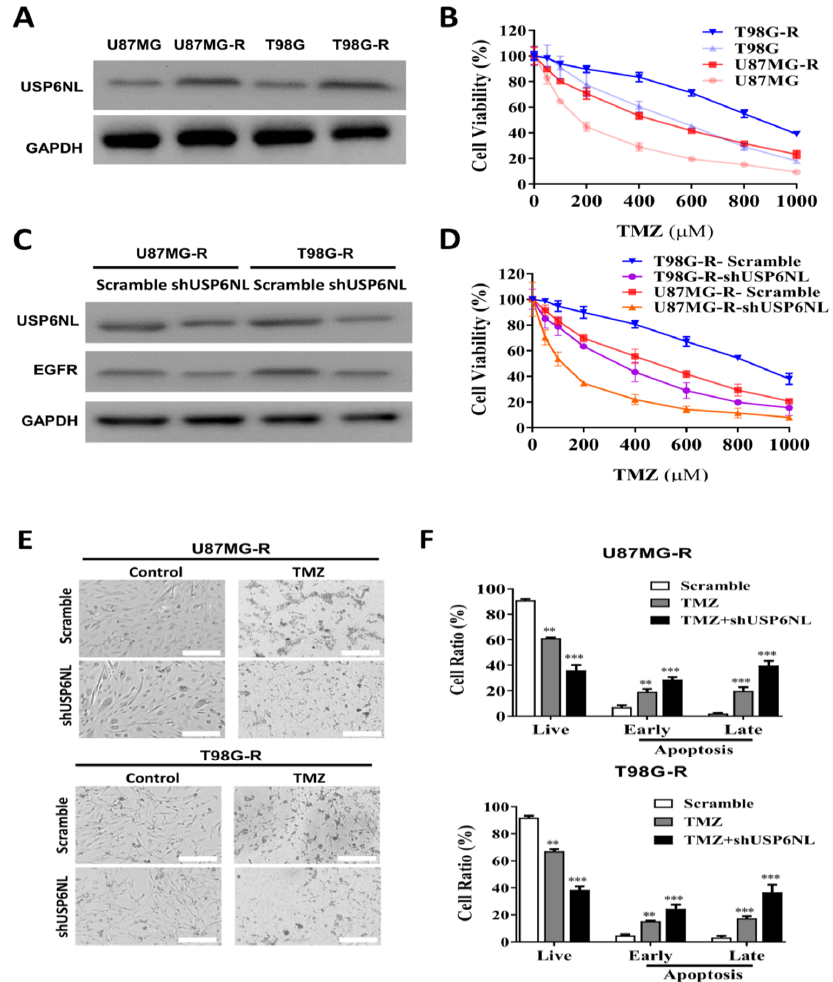
resistant cells (U87MG-R and T98G-R). The Western blot analysis results revealed signifi- cantly reduced USP6NL expression in the U87MG-R and T98G-R cells (Figure 2C) and USP6NL expression in the U87MG-R and T98G-R cells (Figure 2C) and notably, reduced notably, reduced EGFR expression (Figure 2C) in both the USP6NL-knockdown U87MG- EGFR expression (Figure 2C) in both the USP6NL-knockdown U87MG-R and T98G-R cells, R and T98G-R cells, demonstrating a positive association between USP6NL and EGFR in demonstrating a positive association between USP6NL and EGFR in TMZ-resistant GBM TMZ-resistant GBM cells. The proliferation of USP6NL-knockdown U87MG-R and T98G- cells. The proliferation of USP6NL-knockdown U87MG-R and T98G-R cells was examined R cells was examined using a CCK-8 assay. As shown in Figure 2D, under dose-dependent using a CCK-8 assay. As shown in Figure 2D, under dose-dependent exposure of TMZ, exposure of TMZ, loss of USP6NL reduced viability and change in morphology compared loss of USP6NL reduced viability and change in morphology compared with the controls with the controls (scramble) in both the U87MG-R and T98G-R cells (Figure 2E). Enhanced (scramble) in both the U87MG-R and T98G-R cells (Figure 2E). Enhanced TMZ-induced TMZ-induced early and late apoptosis, cytotoxicity, and reduction in viable cells were early and late apoptosis, cytotoxicity, and reduction in viable cells were observed in both the USP6NL-knockdown U87MG-R and T98G-R cells (Figure 2F).